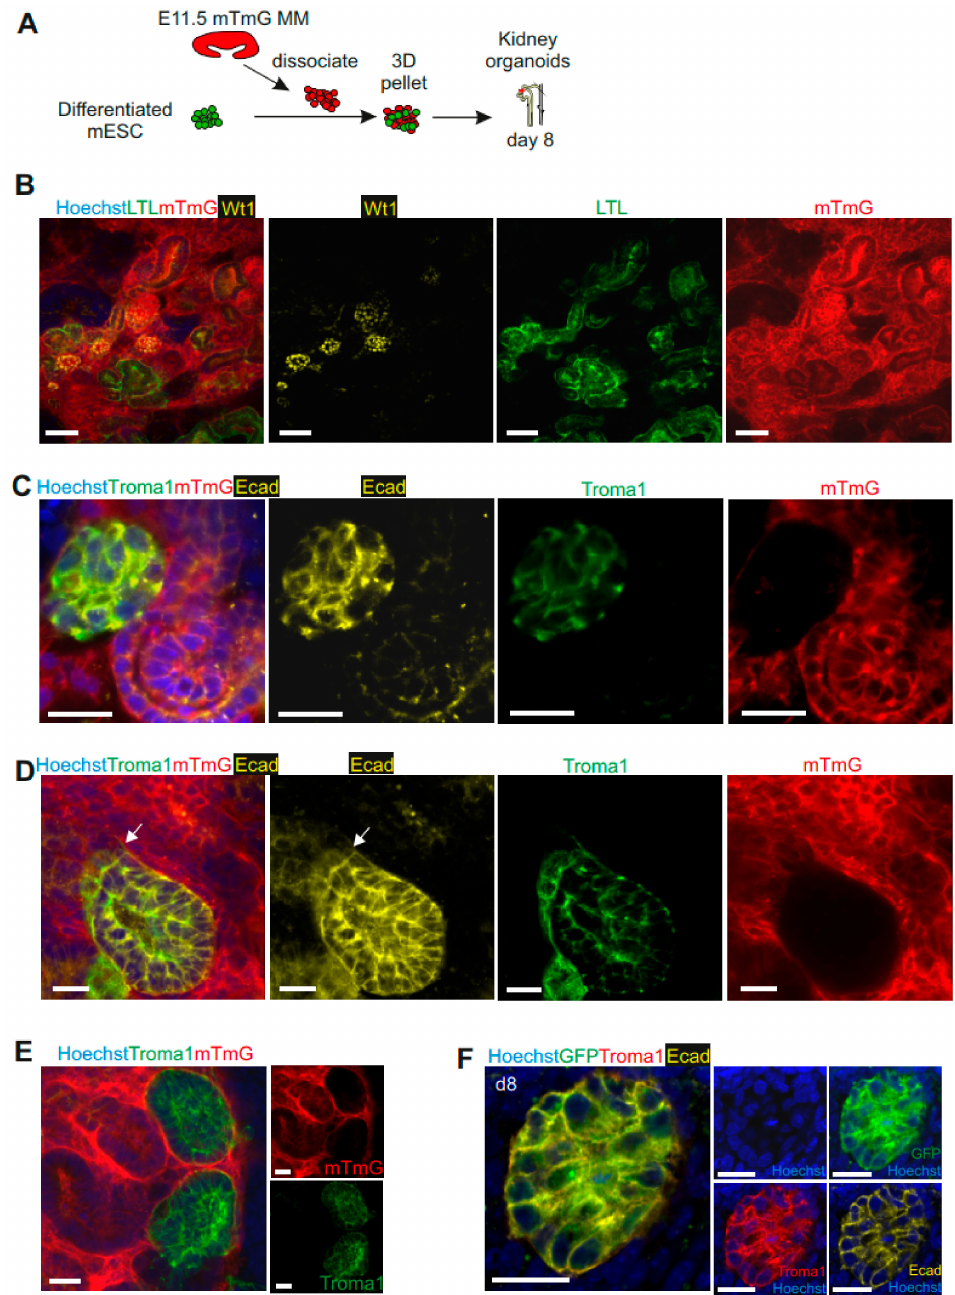
Figure 3. UB structures in kidney organoids are specifically derived from di ff erentiated mESCs. ( A ) Schematic of generation of kidney organoids from mESC-derived UB progenitors with mouse E11.5-dissociated mTmG (td-tomato + ) pMM. ( B ) Confocal images of three-dimensional (3D) kidney organoids derived from E11.5 mTmG + pMM and mESC-derived UB progenitors. Nephron structures such as WT1 + glomeruli and LTL + proximal tubules were derived from mTmG + pMM. Scale bars, 50 µ m. ( C ) Confocal images of kidney organoids showing ureteric bud structures (Ecad + Troma1 + ) being generated by mESC-derived UB progenitor cells. Scale bars, 20 µ m. ( D ) Confocal images showed Troma1 + Ecad + collecting duct derived from mTmg– cells (mESC-derived UB progenitors) and connected with Troma1–Ecad + renal tubules (connection marked with an arrow). Scare bars, 20 µ m. ( E ) The Troma1 + UB structures derived from mTmG– cells (mESC-derived UB progenitors). Scale bar: 20 µ m. ( F ) Troma1 + Ecad + collecting ducts are derived from GFP + mESCs-derived UB progenitors. Scale bar: 20 µ